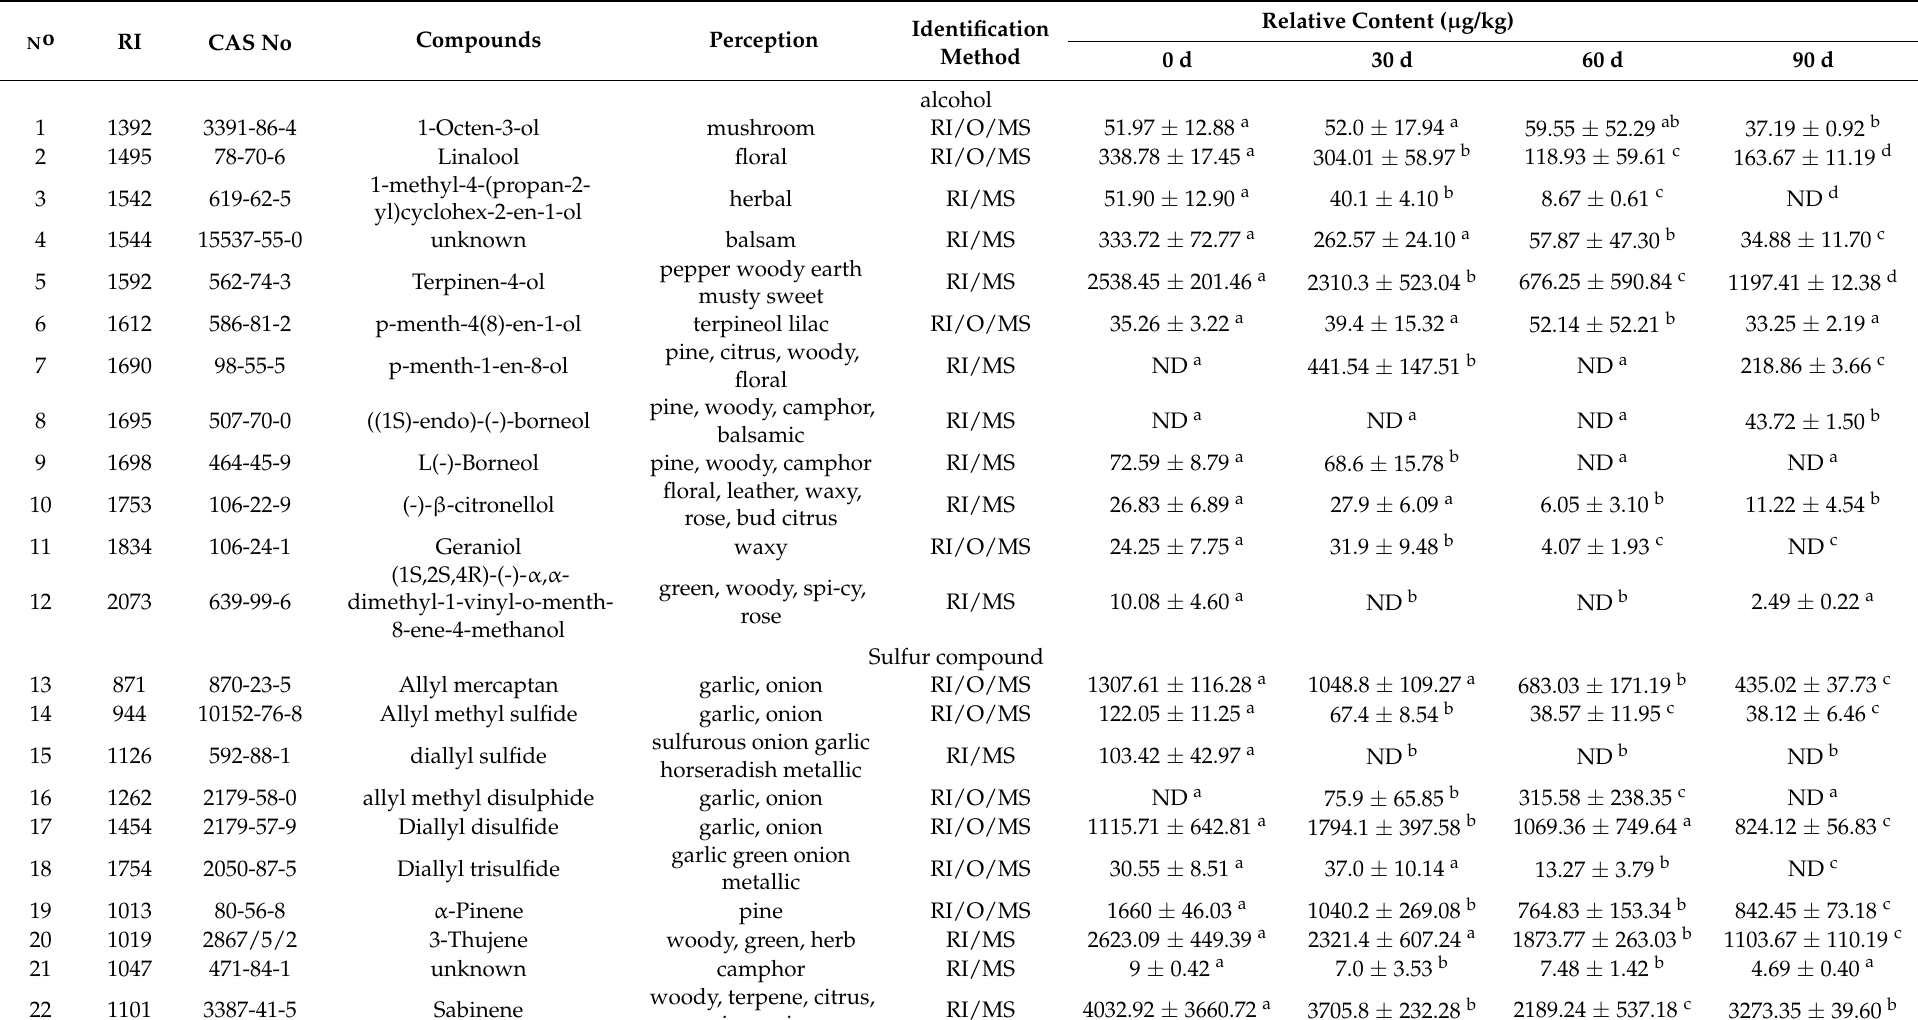
Table 1. Volatile compounds identified by SPME GC-O-MS during the storage period of cooked mutton